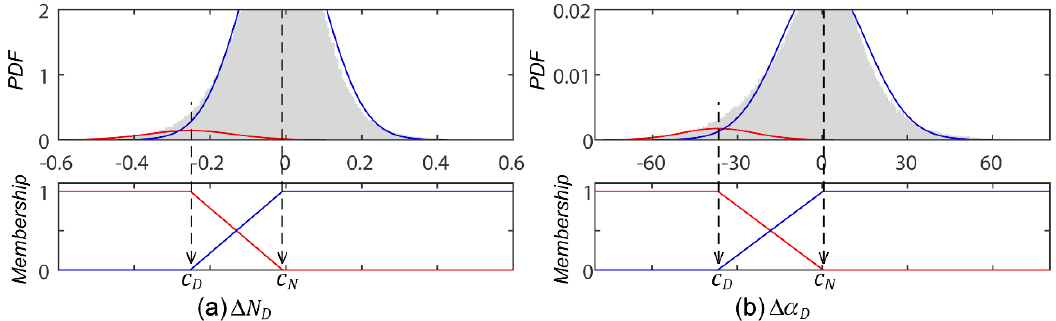
Figure 9. Construction of fuzzy membership functions for the damaged (red) and undamaged (blue) classes in each damage indicator ( a ) ∆ N D and ( b ) ∆ α D